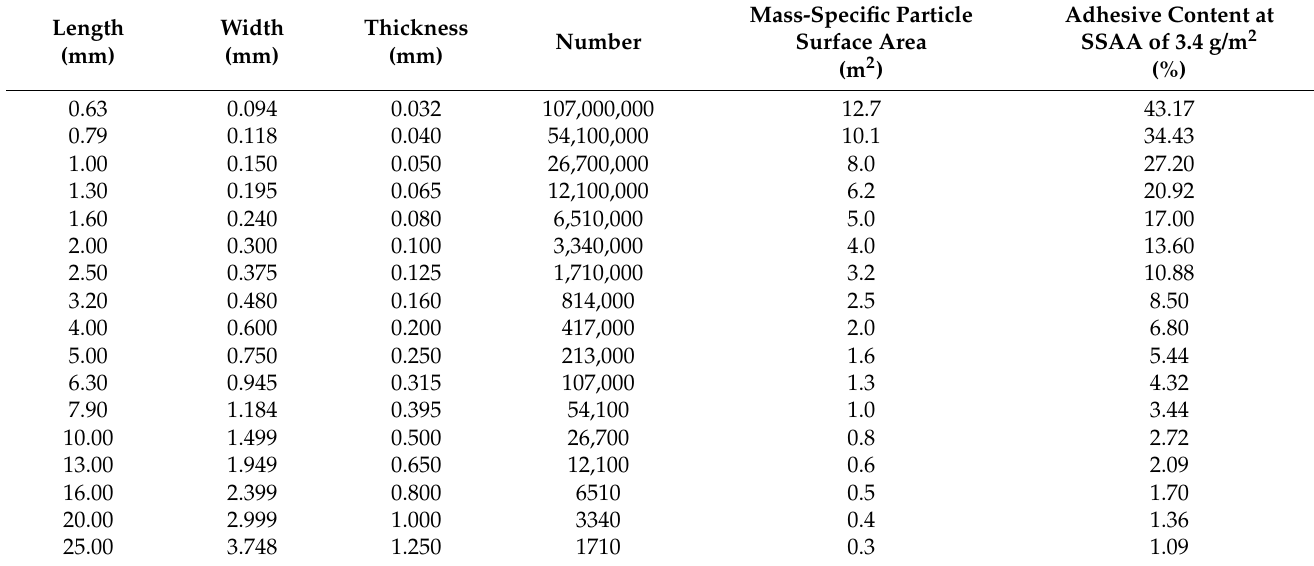
Table 5. Selection from the fictitious data set given and used by Dunky (1988) [23].